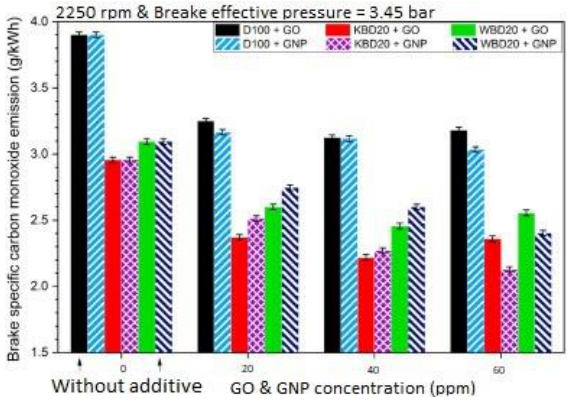
Fig. 13. Variation of CO emission depending on the concentration GO [5] The maximum reduction reported for 40 ppm GO in the case of diesel is 21.9% while for biodiesel blends it is 27% and 22.7%. Increase in the GO concentration did not cause increase in the reduction, which is explained as in previous results by its ability to agglomerate